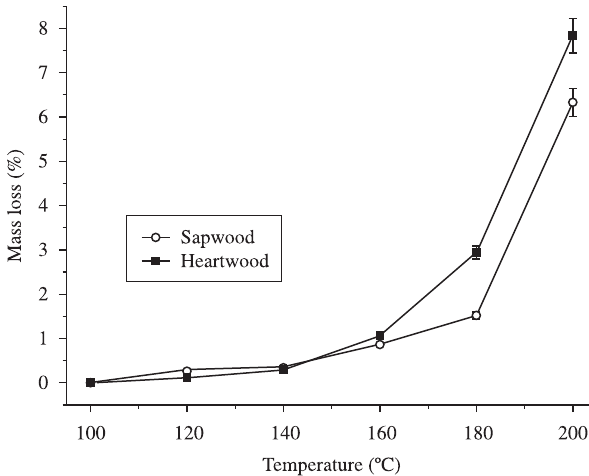
Figure 2. Mass loss with temperature for Araucaria angustifolia (sapwood and heartwood).